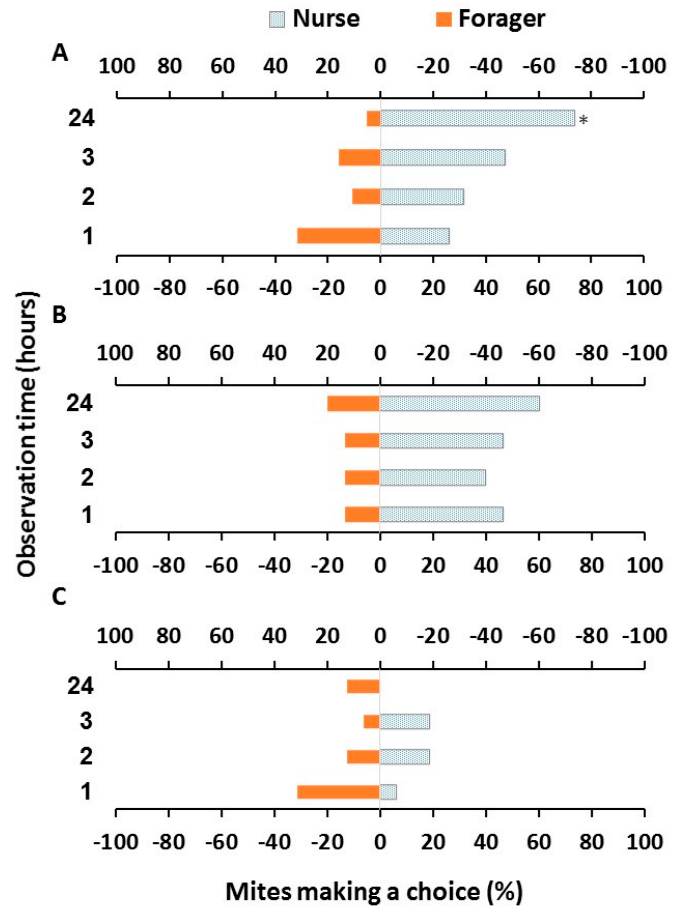
Figure 2. Host selection (%) of surviving mites at the end of the experiment, for unvarnished mites, n = 19 ( A ), mites with varnished idiosoma, n = 15 ( B ) and mites with varnished forelegs, n = 16 ( C ) at 1, 2, 3 and 24 h. Bars with asterisks (*) indicate significant difference in host selection between a nurse and a pollen forager bee (Chi-Square test, p < 0.05).